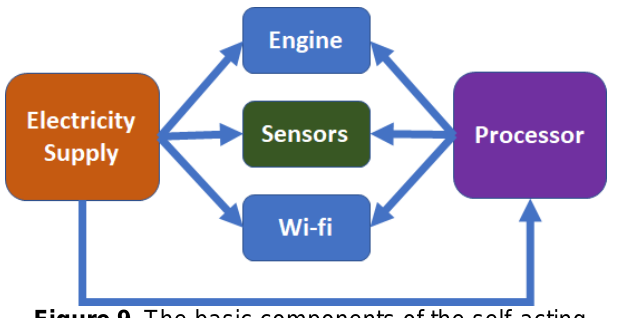
Figure 9. The basic components of the self-acting